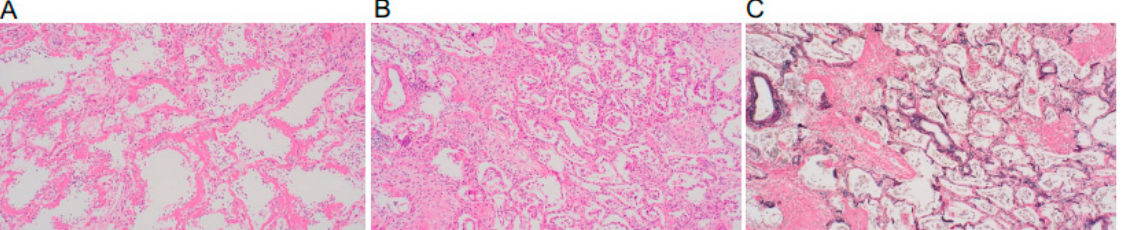
Figure 3. The lung sections obtained from autopsy were stained with the hematoxylin–eosin stain ( A , B ) and the Elastica van Gieson stain ( C ). Representative images of ( A ) hyaline membranes’ line alveolar spaces, ( B ) fibroblastic foci, and ( C ) fibrotic lung tissue are shown (original magnification × 200).